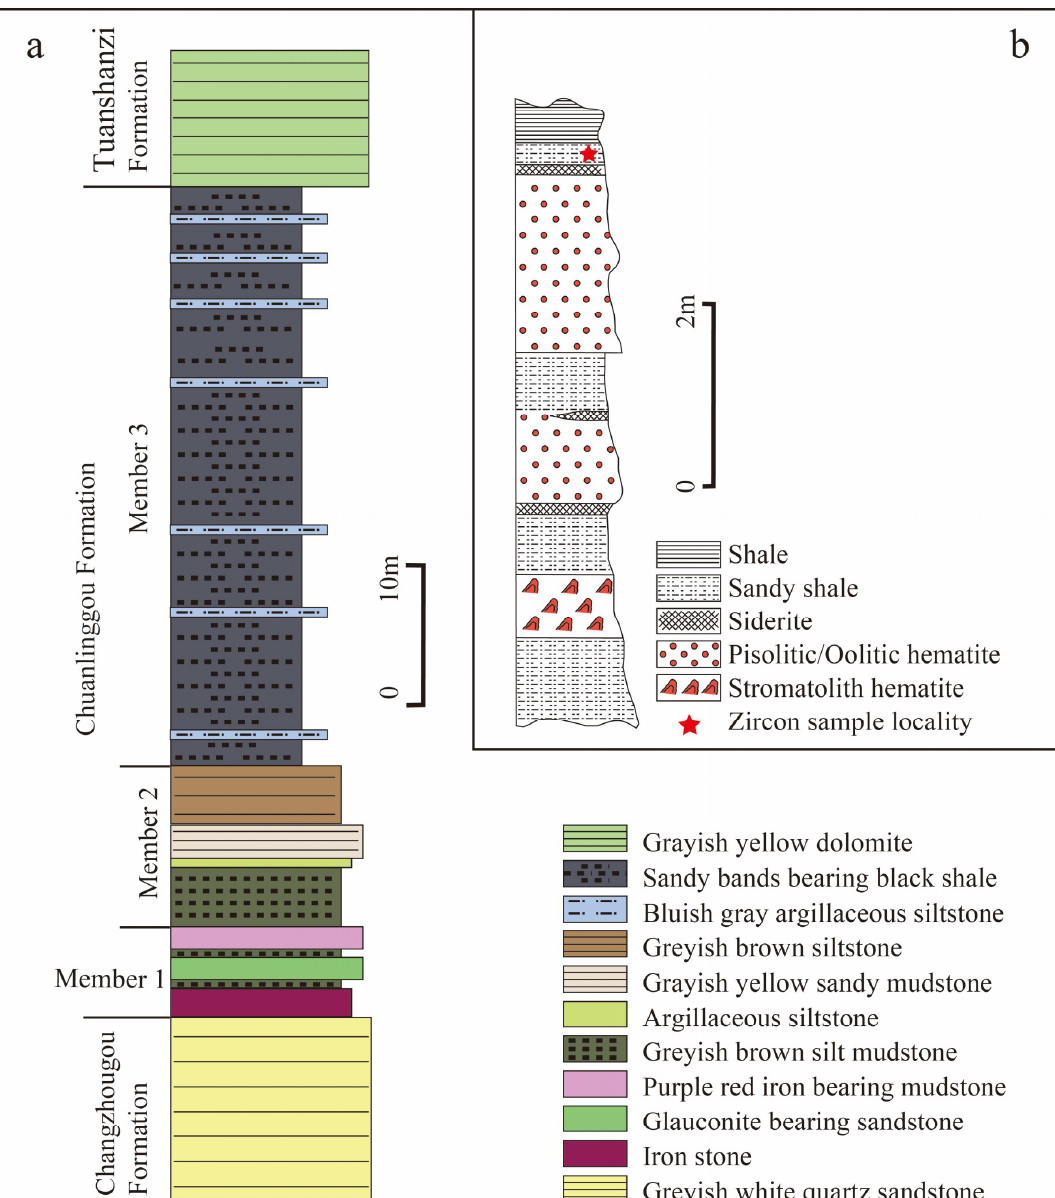
Figure 2. ( a ) Ironstone and related sedimentary successions in the Chuanlinggou Formation at the Xuanhua area (modified after Tang et al., 2015 [47]); ( b ) A representative iron ore-bearing sequence of the Chuanlinggou Formation (modified after Zhao, 1994 [48]).